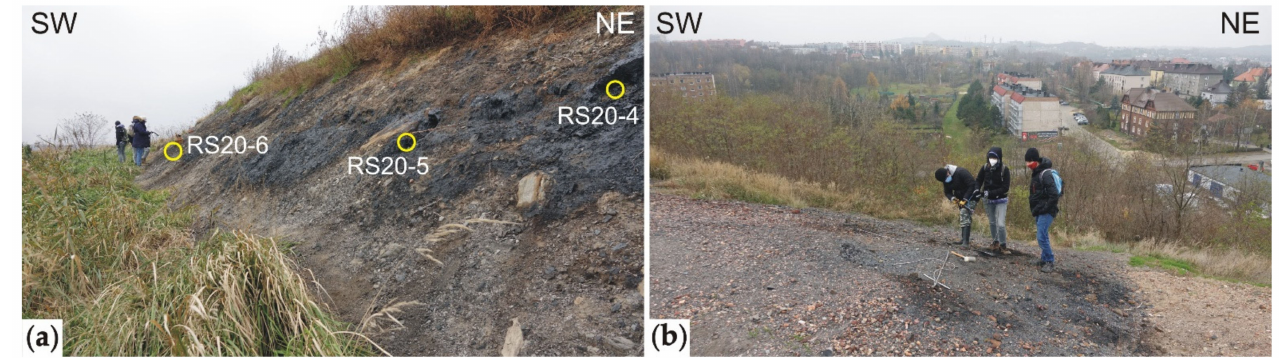
Figure 2. Thermally active areas on Rymer coal waste dump on 26 November 2020: ( a ) RS-20-4, RS-20-5 and RS-20-6 sampling sites at SE slope; ( b ) gas collection followed by temperature measurement in RS-20-8 sampling site at SW slope of the dump, which is located next to the housing estate of Rybnik